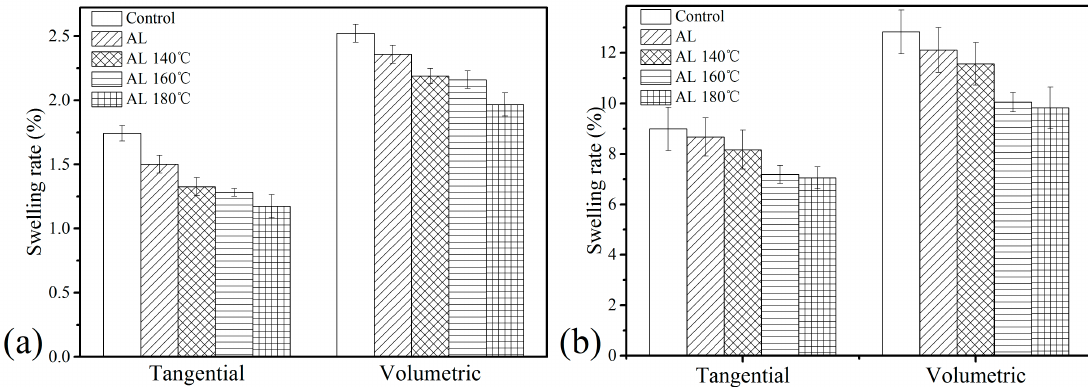
Figure 9. Tangential and volumetric swelling rate of the samples: ( a ) through moisture adsorption (54% RH) and ( b ) through water absorption after 20 days’ immersion.